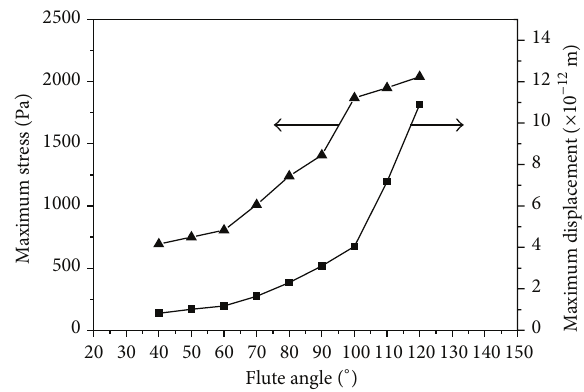
Figure 10: Maximum stresses and maximum displacements of corrugated board models with different arc radius of flute.